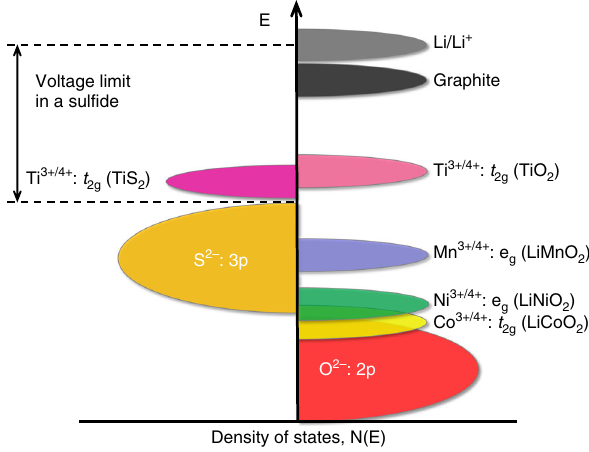
Fig. 1 Positions of the redox energies relative to the top of the anion: p bands. The top of the S 2 − :3p band lying at a higher energy limits the cell voltage to <2.5 V with a sul fi de cathode. In contrast, the top of the O 2 − :2p band lying at a lower energy enables access to lower-lying energy bands with higher oxidation states and increases the cell voltage substantially to ~4